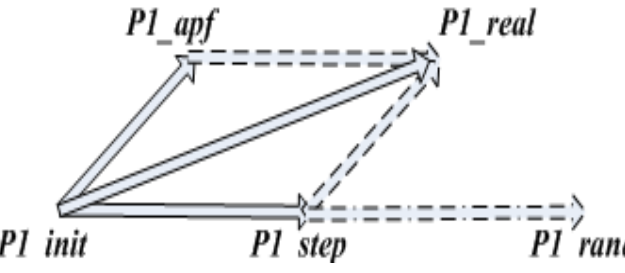
Figure 4. Sampling with the addition of artificial potential field concepts.